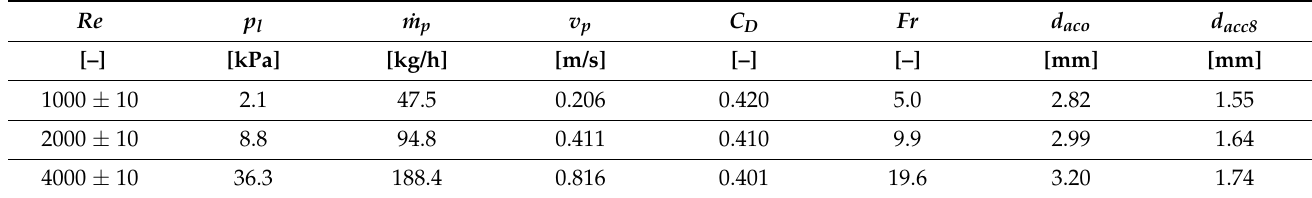
Figure 1. Atomizer schematic drawing with main dimensions in millimetres. Table 2. List of operating regimes.